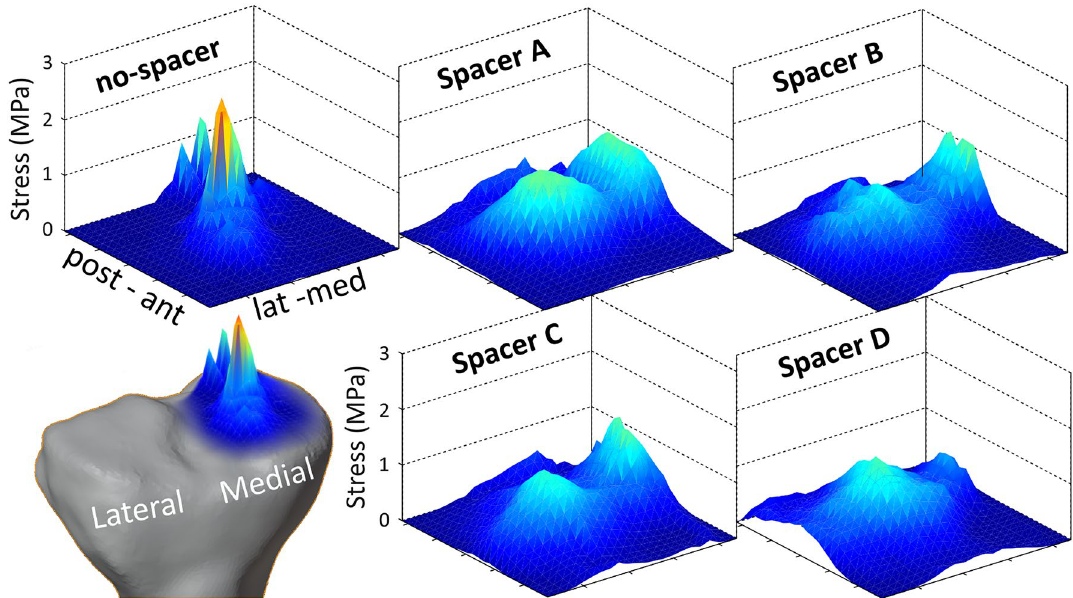
Figure 6. Heat map. Mean stress heat map of the medial knee condyle for no-spacer and four tested spacer